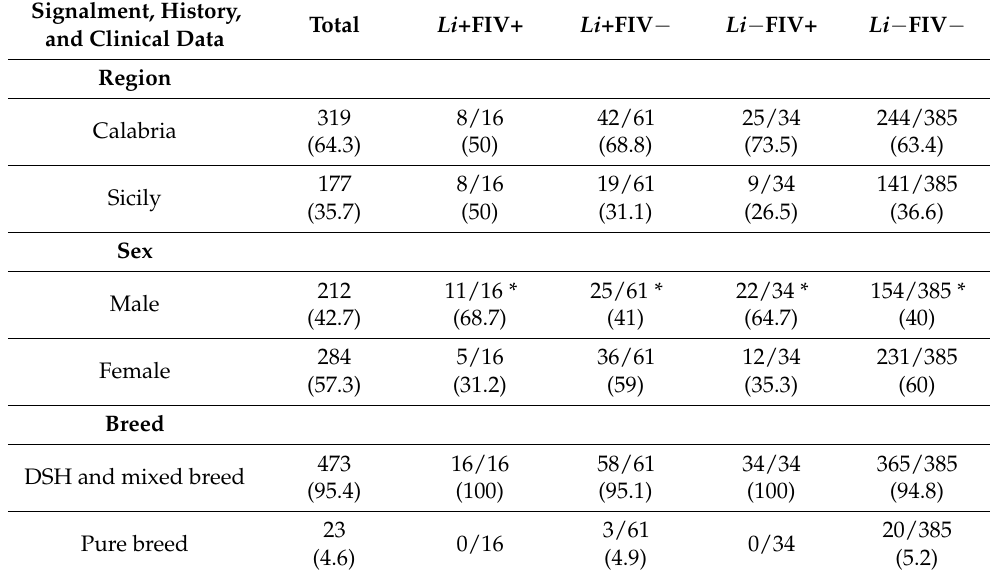
Table 2. Data from signalment, history, and clinical examination ( n (%)) of total enrolled cats (total) and of the cats classified according to their infection pattern ( Li +FIV+; Li +FIV − ; Li − FIV+; Li − FIV − ). Signalment,